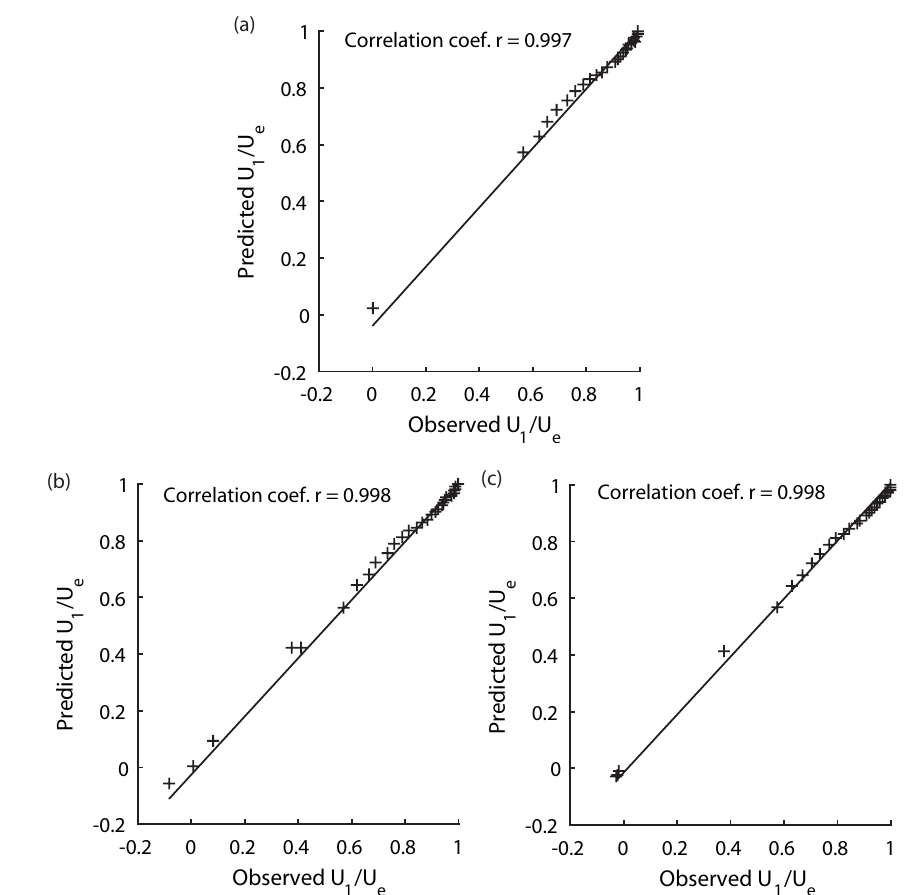
Figure 5. Comparison of vertical profiles of predicted mean-flow velocity U 1 for Run 1 with available observations [13] at three locations: ( a ) x 1 / λ ≈ 6.5, ( b ) x 1 / λ ≈ 7, ( c ) x 1 / λ ≈ 7.25. The locations are in the channel center-plane (at x 3 = 0.0375